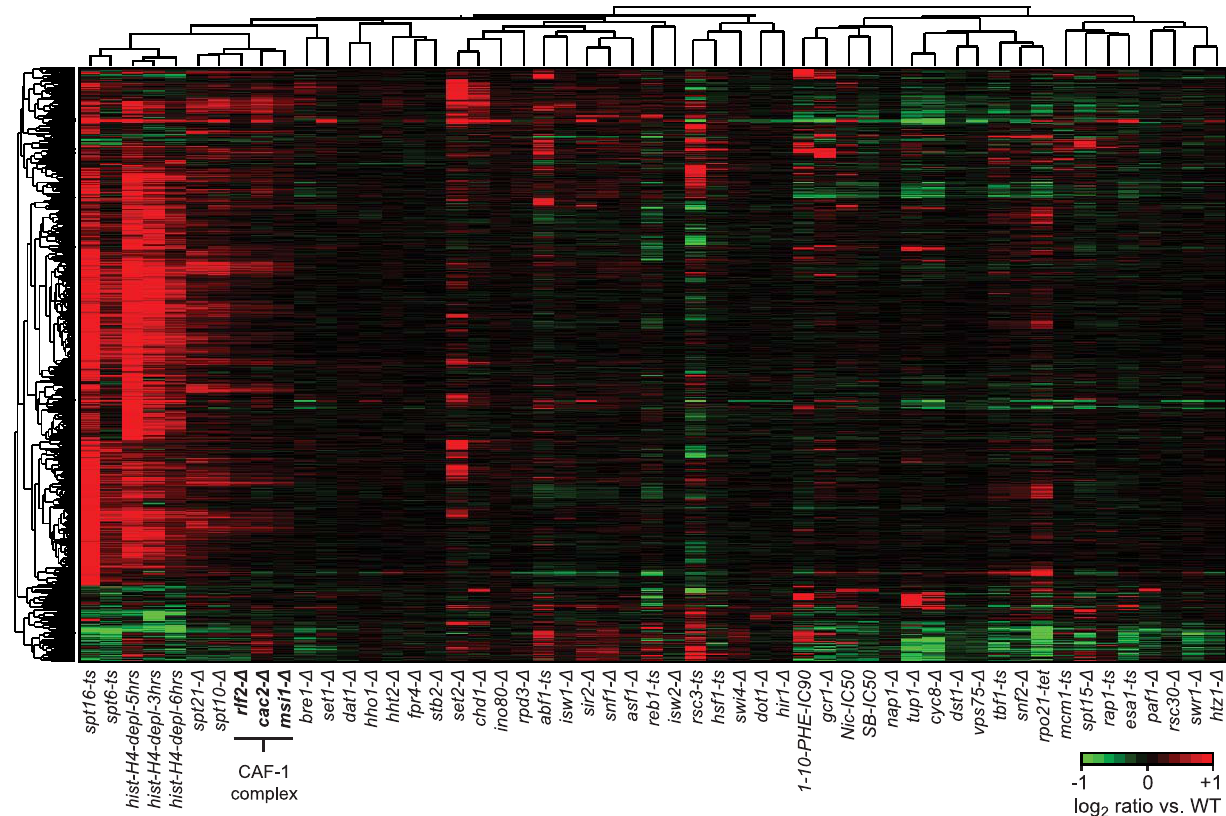
Figure 5. Cryptic antisense transcripts in CAF-1 complex mutants. Hierarchical clustering of average expression changes in 3,578 antisense (AS) regions. The set of AS transcripts was compiled by first identifying all AS transcripts with a more than 2-fold change in expression and a p-value , 0.05 over at least 80 bp (10 probes) in at least one compendium condition, and then combining these transcripts in a non-redundant union set. Four strains ( rpa190-tet , rpb2-tet , rrn3-tet , bdp1-tet ) were excluded from the analysis as the large decrease in gene expression and/or global changes in total RNA composition in these strains made them unsuitable to our tiling array normalization procedure. Profiles corresponding to deletions of subunits of the CAF-1 complex are indicated in